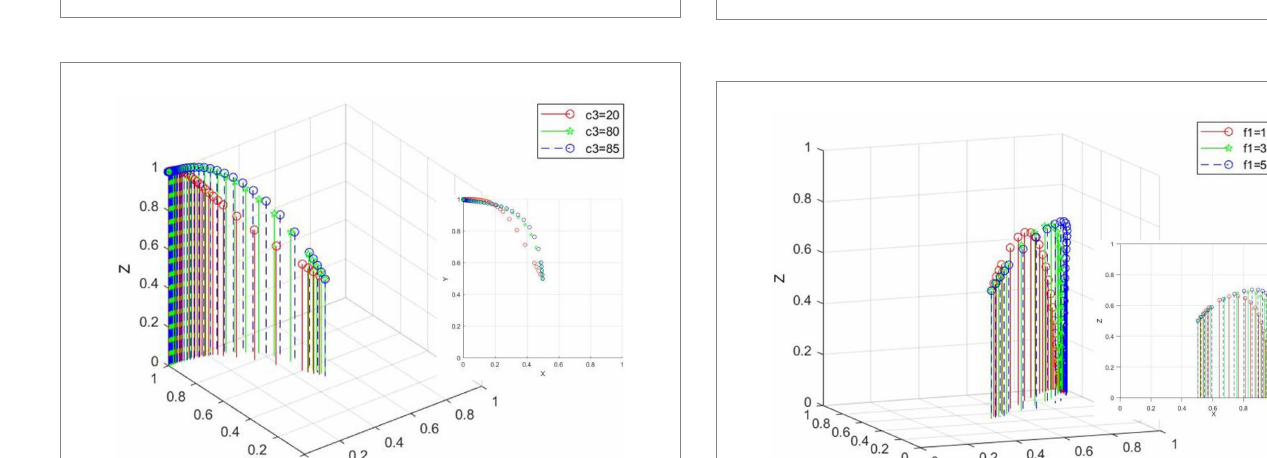
FIGURE 6 Impact map of government subsidies (Scenario